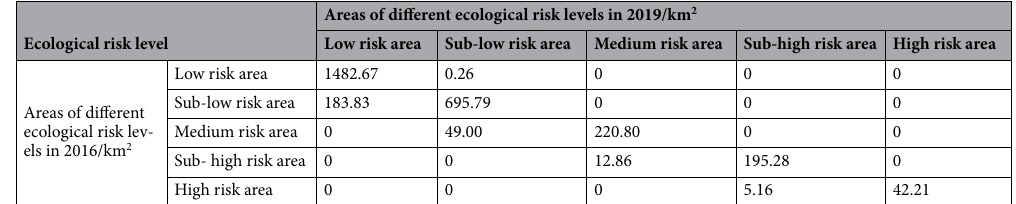
Table 6. Transfer matrix of ecological risk levels in the 10-km buffer zone along the highway in 2016–2018.